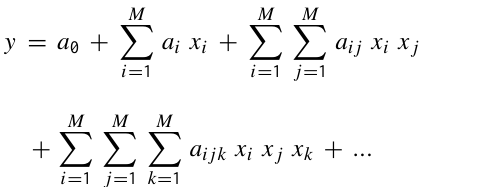
Fig. 3. Architecture of